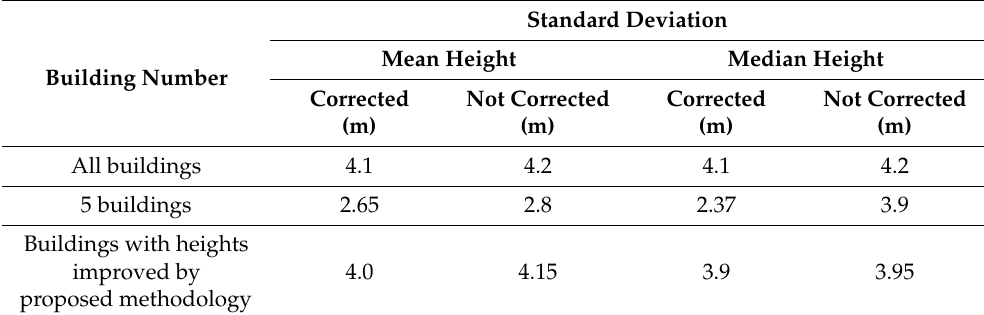
Table 7. Standard deviation obtained for two methods for deriving building height: mean and median height for the points inside the building